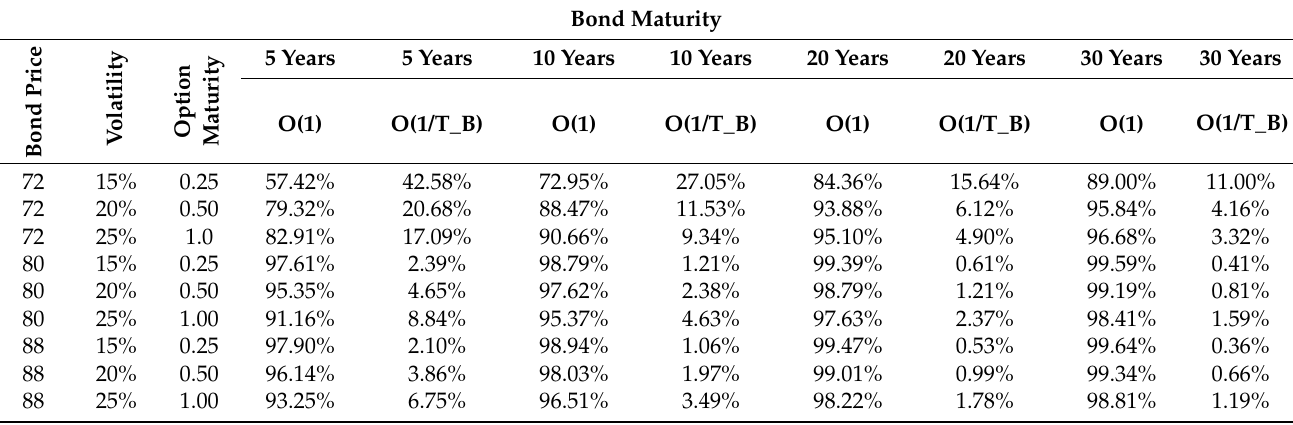
Table 2. Contribution of terms to PTP values: strike price 80, risk free rate 0.5%. Bond